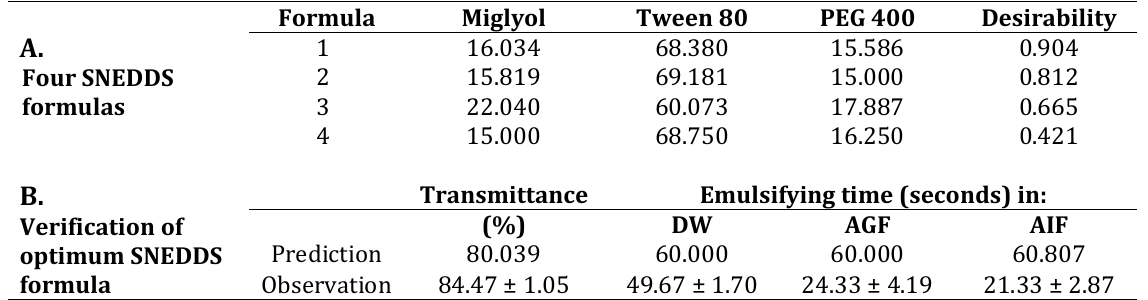
Table III. Four SNEDDS formulas and verification of the optimum formula